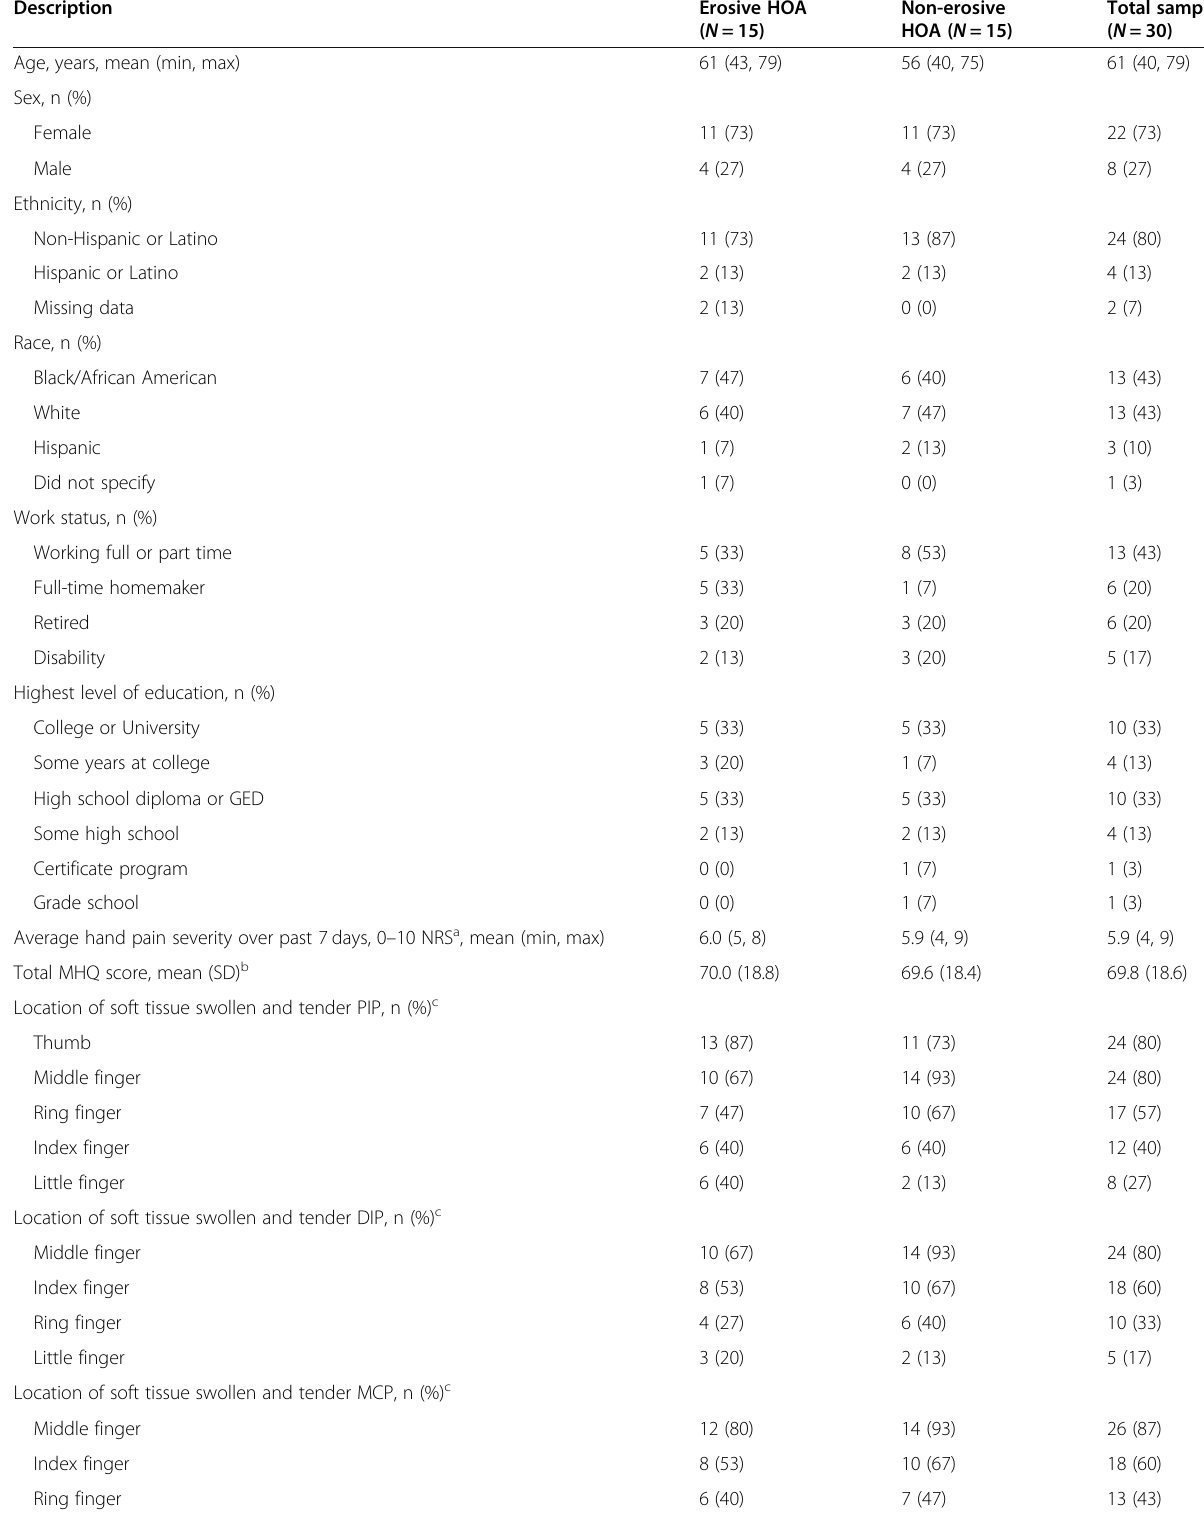
Table 1 Patient demographics and